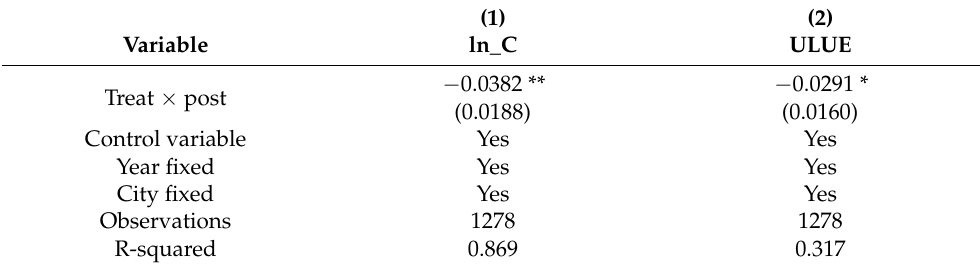
Table 6. Robustness